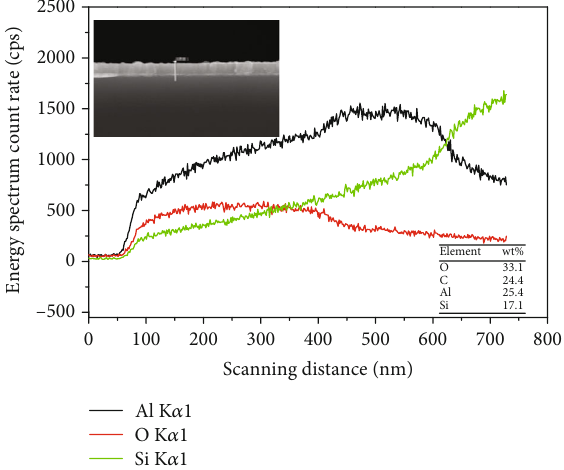
Figure 2: The AES spectrum of Al/Al